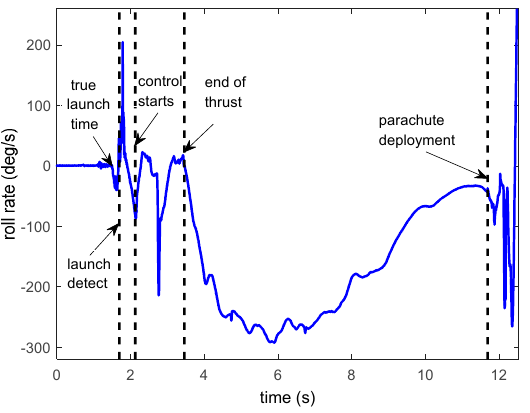
Figure 18. Roll rate response for Tasha III launch 1 including key points in the launch.